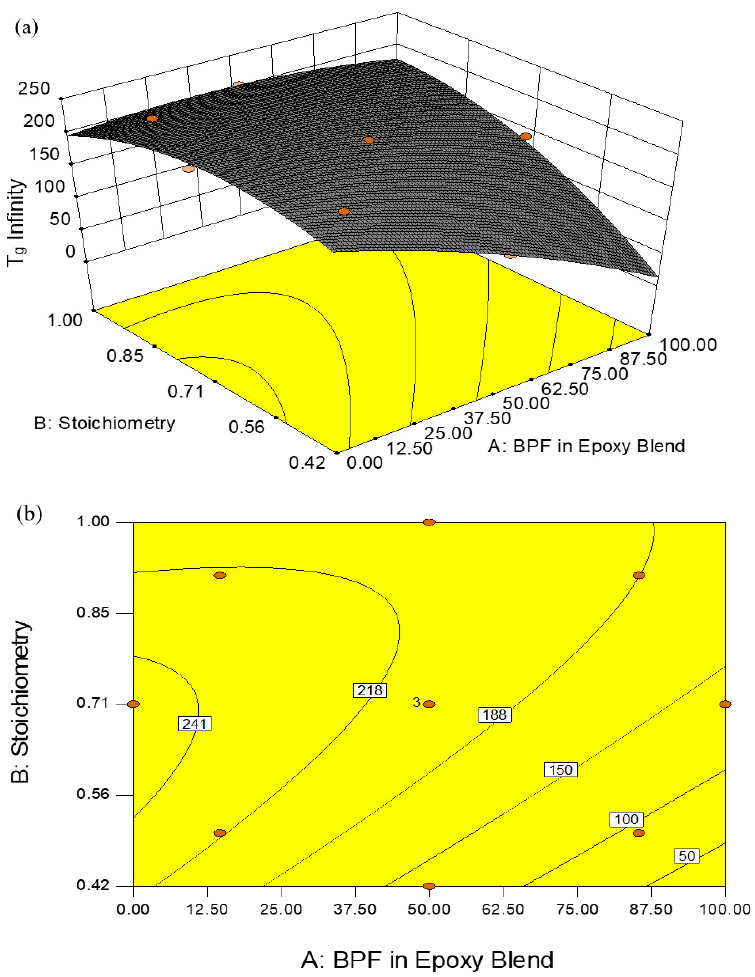
Figure 10. Response surface for T g of BPF/TGPAP/DDS epoxy resins ( a ) 3D plot and ( b ) contour plot.